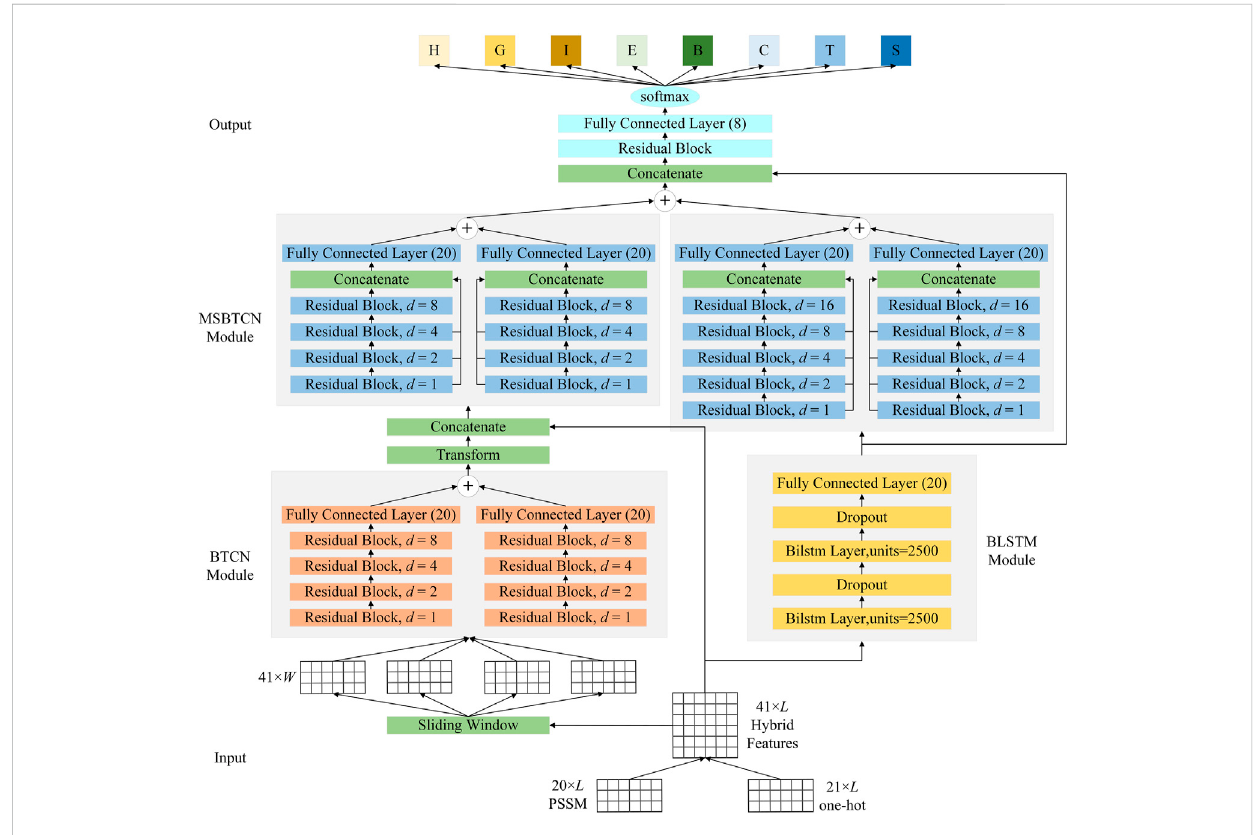
FIGURE 5 The detailed architecture of the proposed